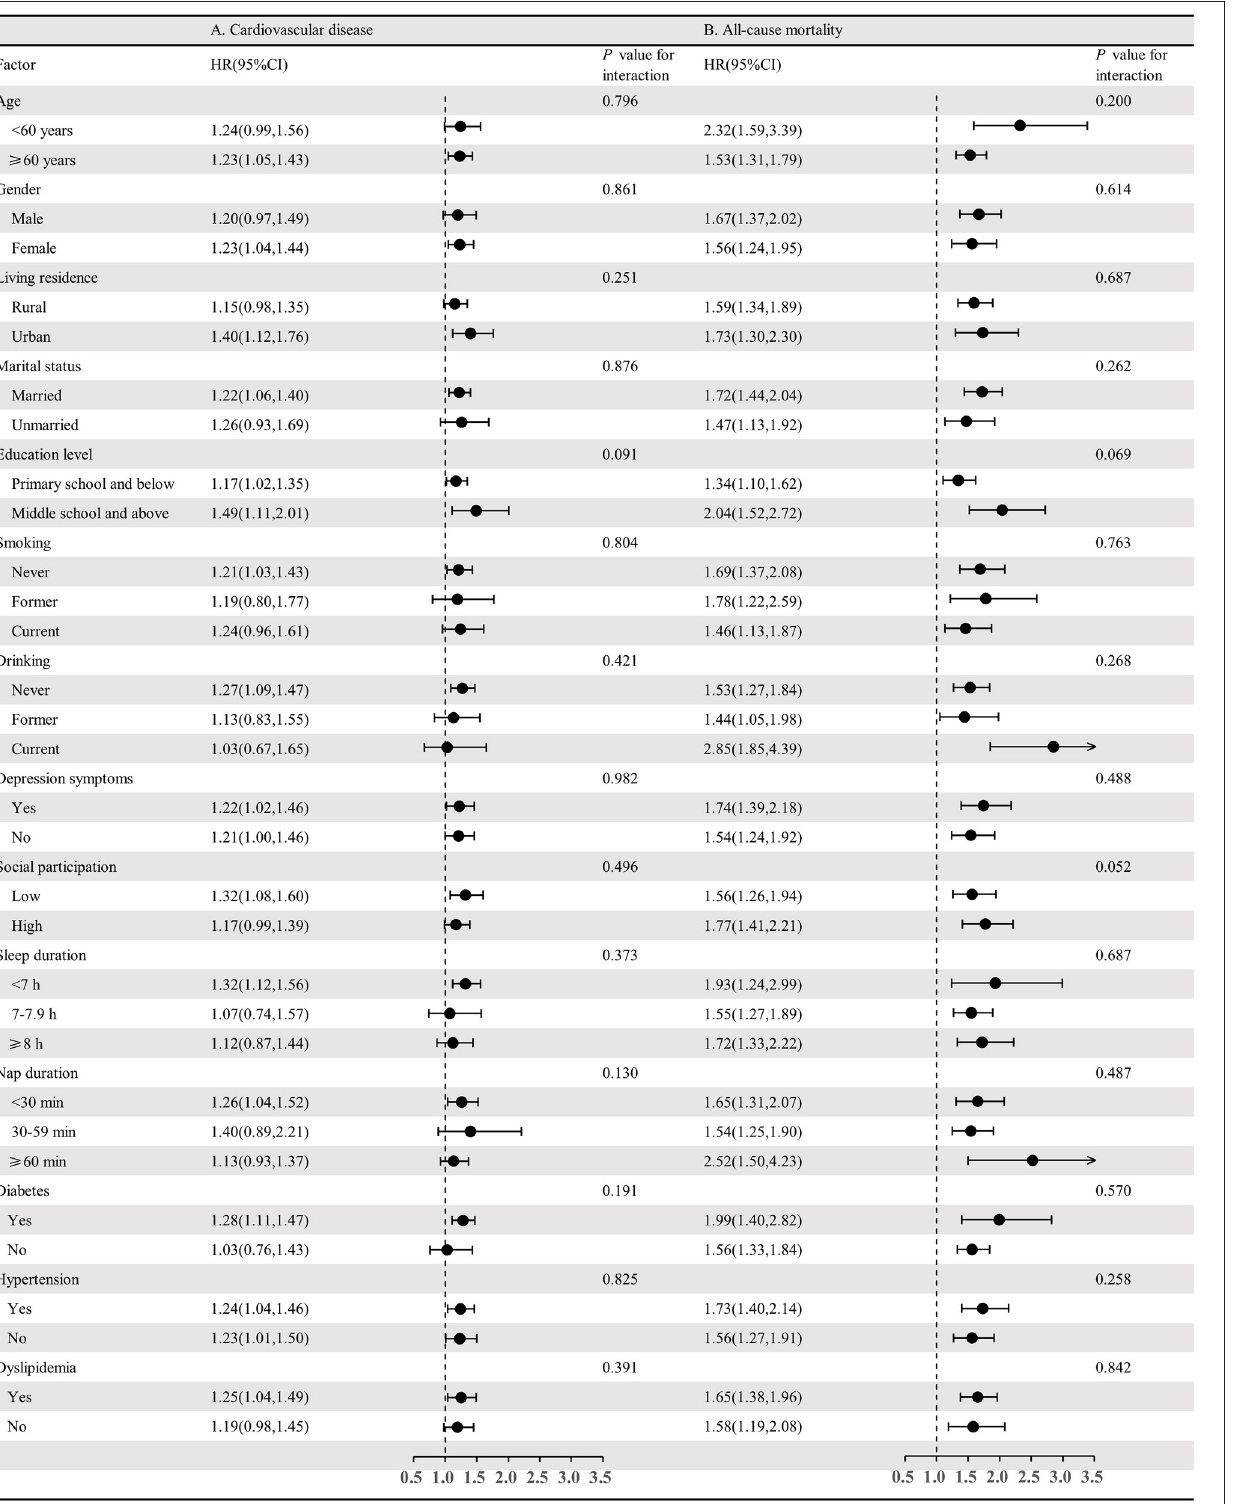
FIGURE 2 | Association between functional limitation and risk of cardiovascular disease and all-cause mortality stratified by different factors. (A) Adjusted HRs for association between functional limitation and CVD; (B) Adjusted HRs for association between functional limitation and all-cause mortality.